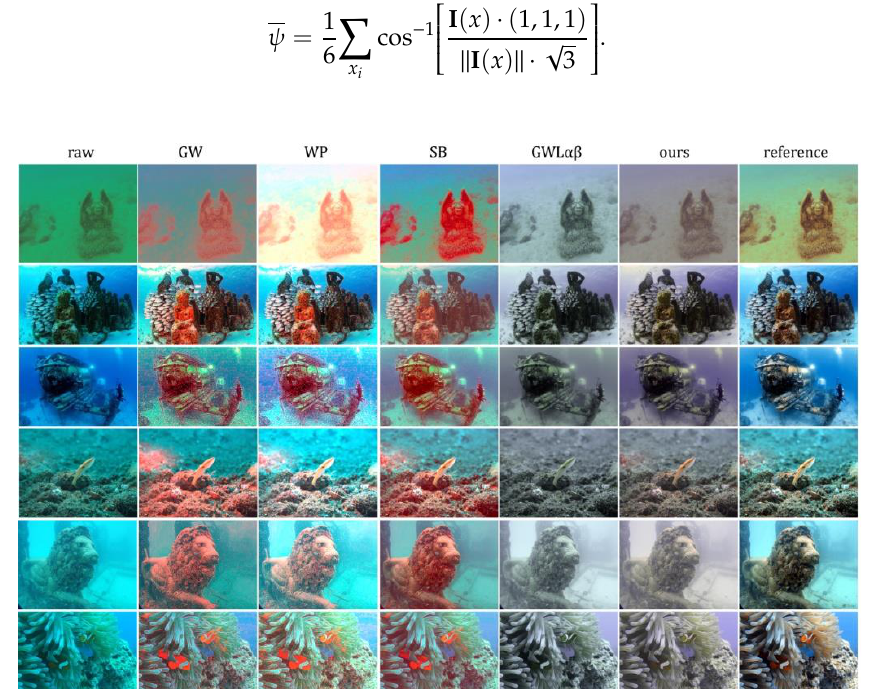
Figure 8. Comparisons on images with severe color cast. From left to right are raw underwater images, the results of gray-world (GW) method, white-patch (WP) method, statistical-based (SB) method [21], Bianco’s (GWLαβ) method [37], proposed method and reference images.